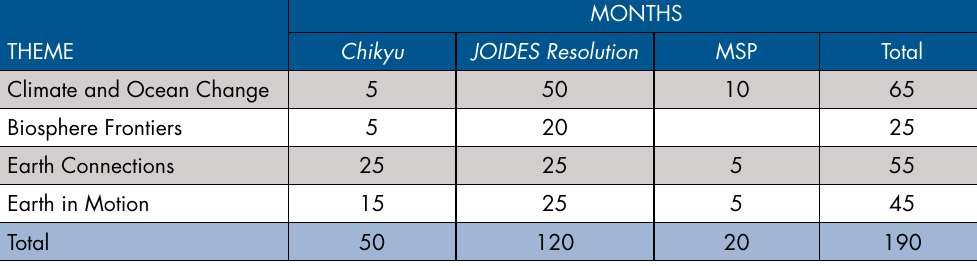
Table 7.1. initial estimates of platform drilling in increments of five months. although distributed across the different science plan themes, many drilling expeditions will address multiple themes. The target is full 12 months/year JOIDES Resolution operation, varying between 8 and 12 months due to logistical and fiscal constraints, and five months/year of Chikyu operations. one mission-specific platform (msp) operation (two months average) per year is expected. The actual amount of drilling time within each theme will depend on proposal pressure and readiness of each project, including site characterization and borehole